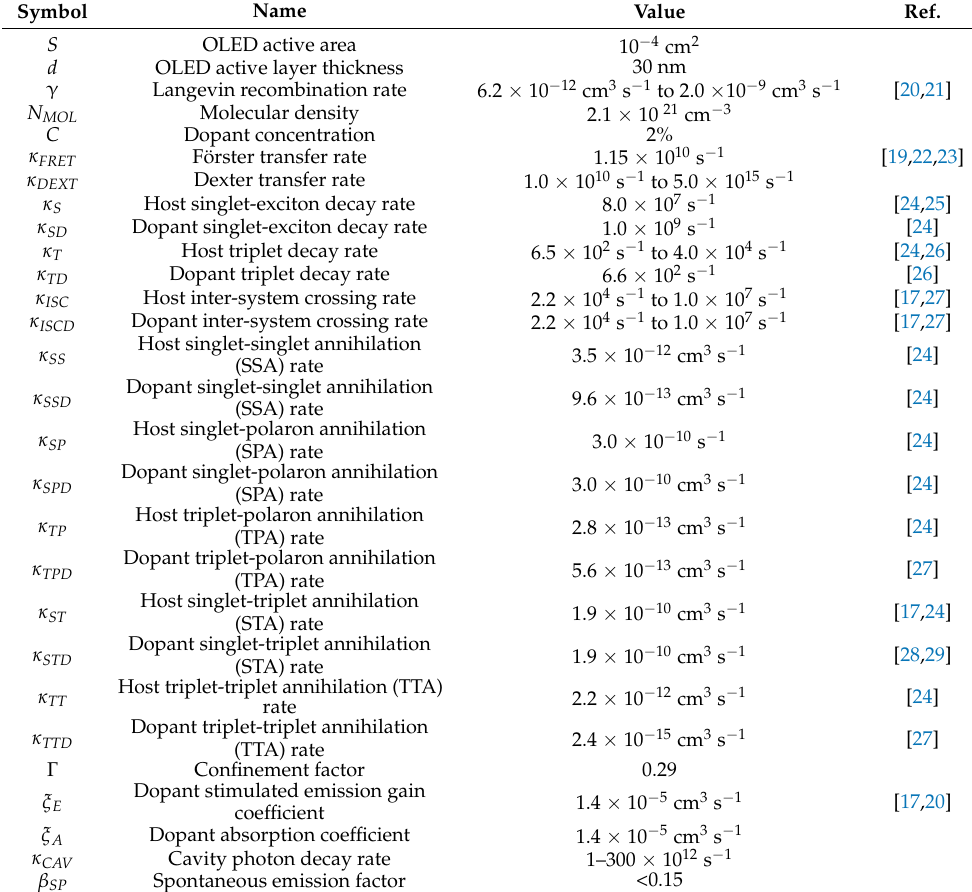
Table 1. Model Parameters